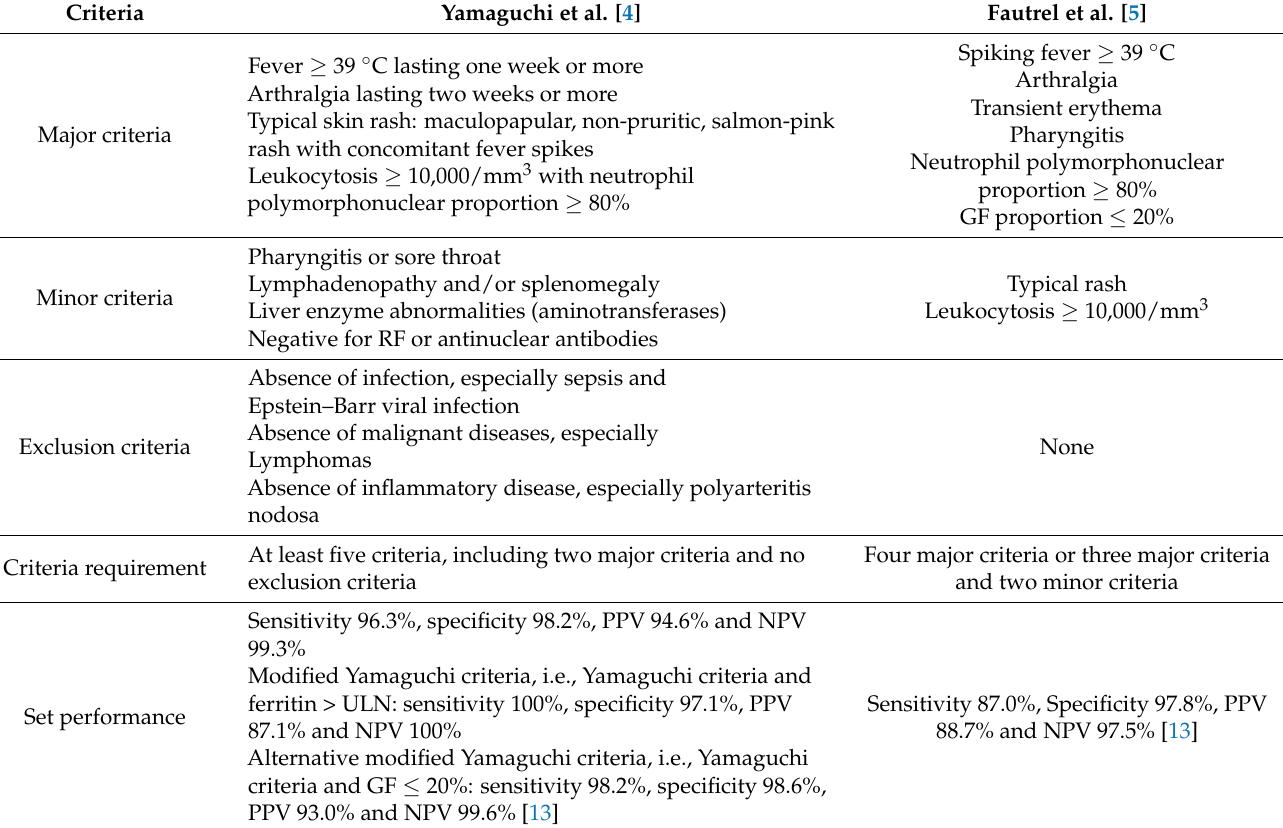
Table 2. Classification criteria for AOSD.